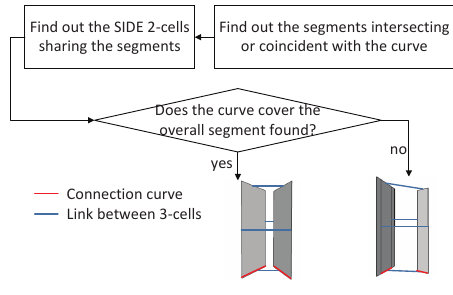
Figure 9. Sew 3-cells by a connection